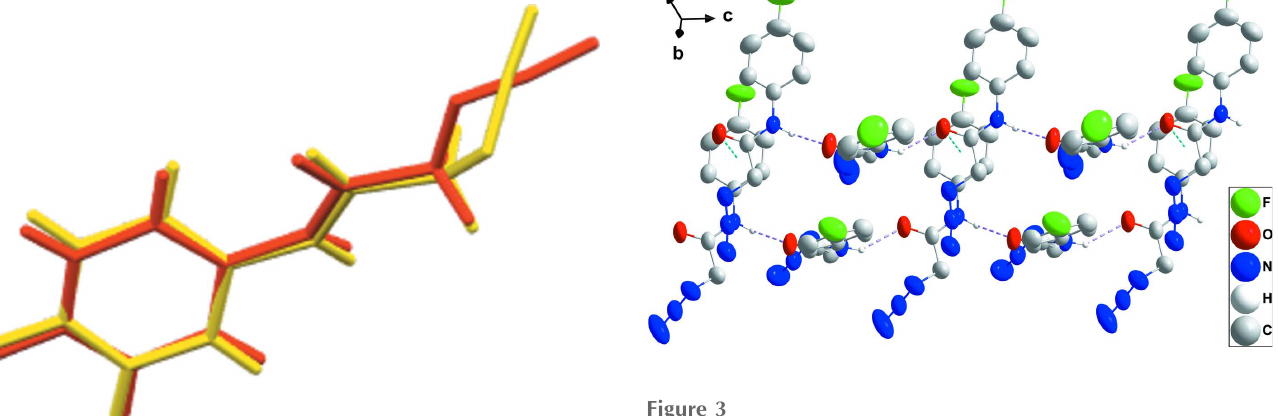
Figure 3 Perspective view of the chain structure with N—H (cid:2)(cid:2)(cid:2) O hydrogen bonds and C15 O2 (cid:2)(cid:2)(cid:2) Cg 1 interactions depicted, respectively, by violet and light-blue dashed lines. Non-interacting hydrogen atoms are omitted for clarity.